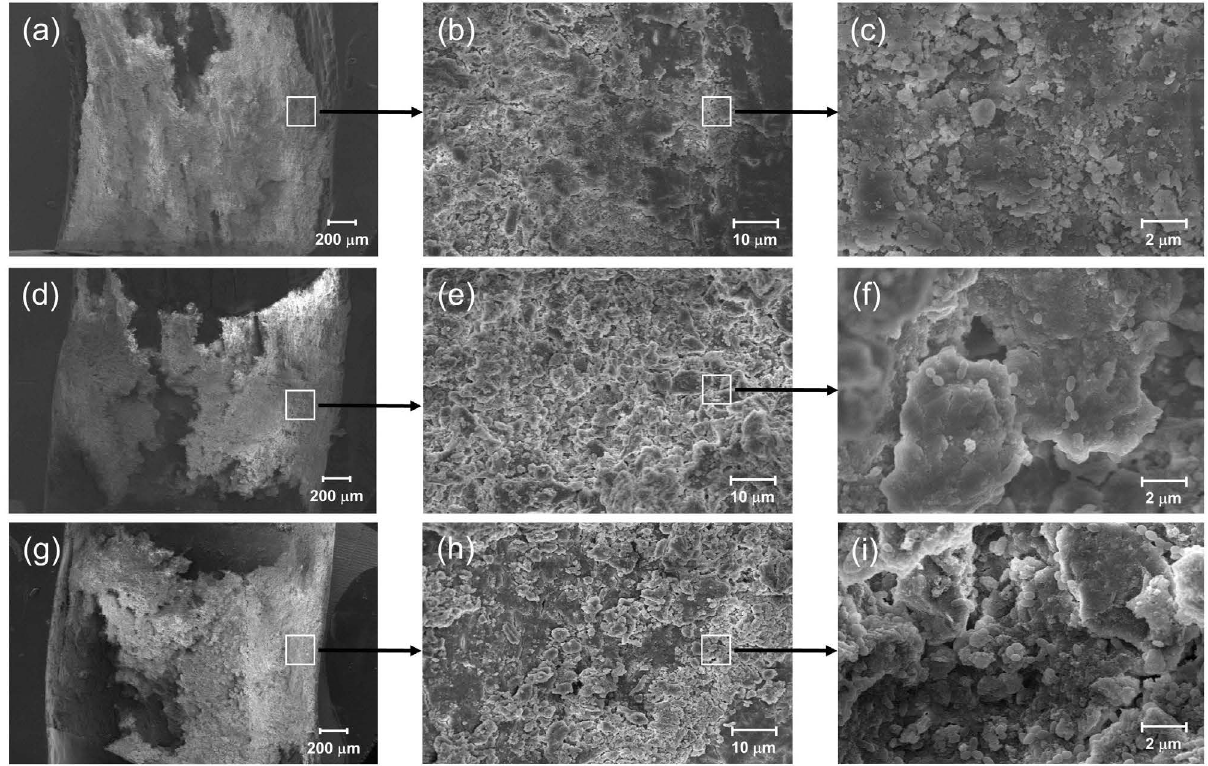
Figure 3- SEM images of E. faecalis biofilm formed in the bovine root canal specimens. (a-c): cultured only in BHI for 2 days (Control), (d-f): treated with DNase for 1 hour after 2-day culture in BHI (DNase-1h), and (g-i): cultured with DNase for 2 days (DNase-2d). Magnification: (a, d, and g) - 30X, (b, e, and h) - 1000X, and (c, f, and i) - 50000X